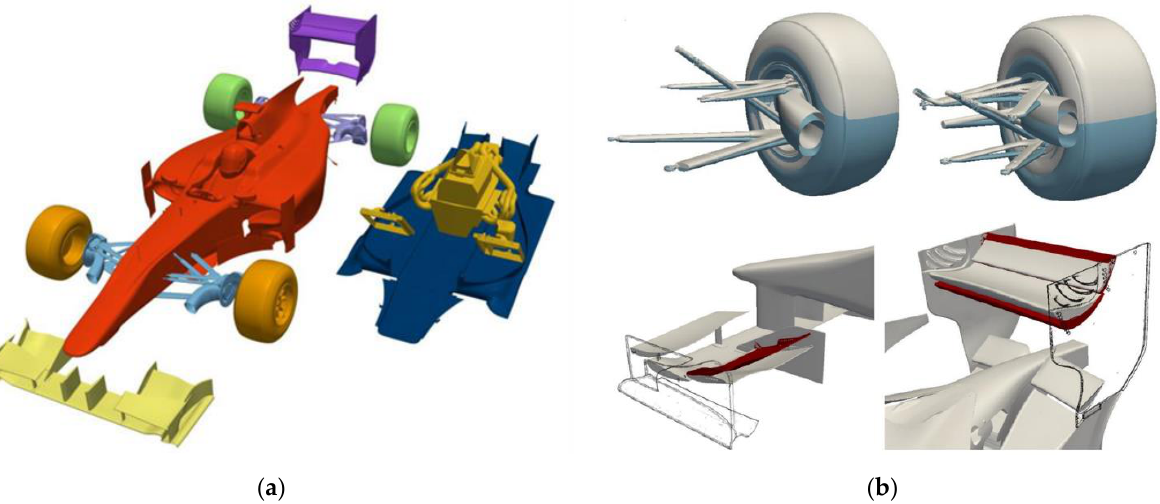
Figure 2. Final 3D model assembly: ( a ) Full vehicle model ready for CFD analysis; ( b ) Adjustable front flap and rear wing and movable suspension kinematics allowed for CFD analysis to be performed as a sweep of aerodynamic device settings and ride heights.